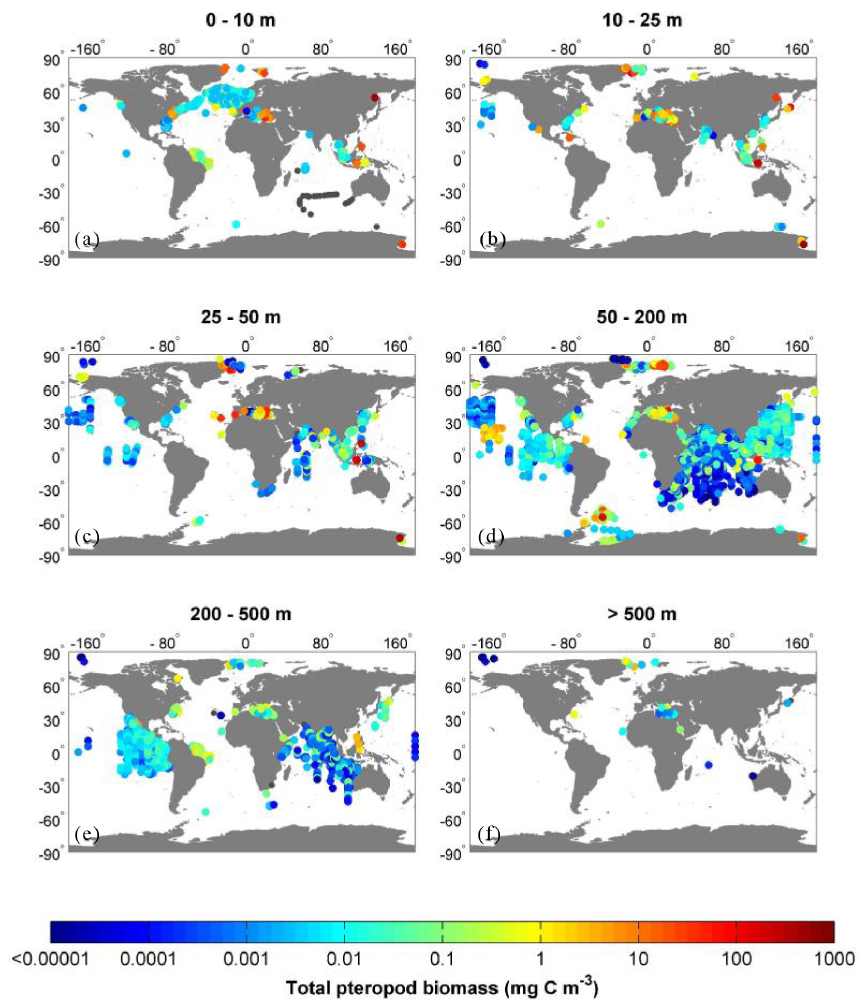
Figure 7. Pteropod carbon biomass (mgCm − 3 ) for six depth intervals: (a) surface (0–10m), (b) 10–25m, (c) 25–50m, (d) 50–200m, (e) 200–500m, (f) ≥